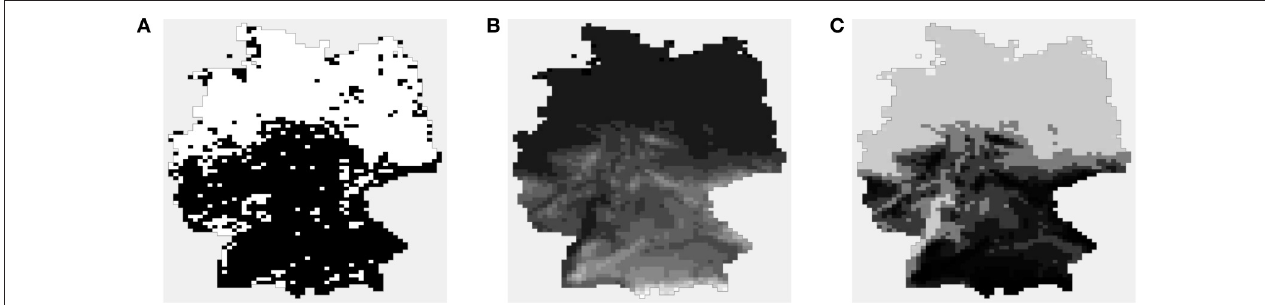
FIGURE 1 | The H. vulgaris data. (A) Observed presence/absence data (white indicates presence, which is taken to be the “high” level). (B) Value of the covariate, altitude. (C) Predicted probabilities from logistic regression. In (B,C) , lighter shades of gray indicate larger